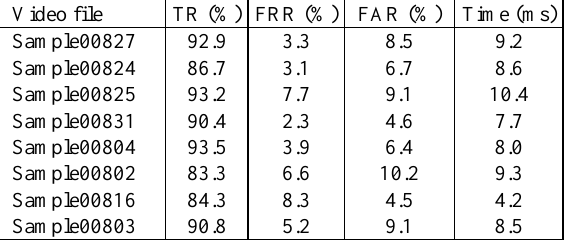
As one can see from Table 2, all true and false segmentation results have close values in ranges of 84-93% and 3-10%, respectively. The deviation is explained by some blurred frames in video files, for example, “Sample00802” and “Sample00816”. The temporal values of frame processing have the same order.